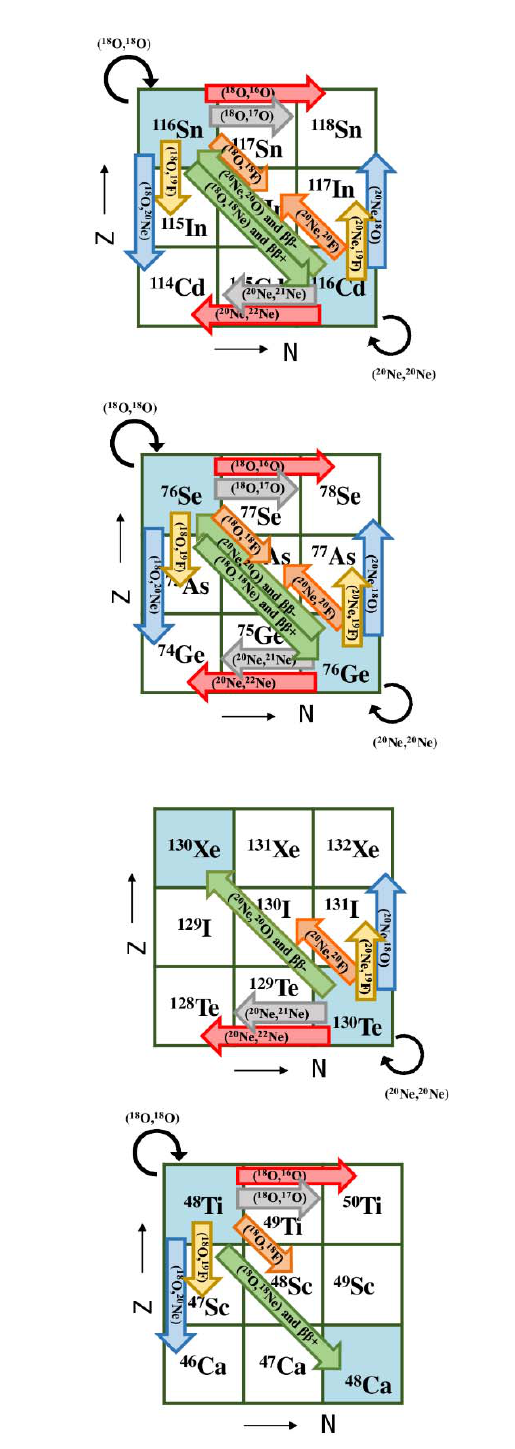
Fig. 2 Scheme of the reaction channels already studied within the NURE and NUMEN